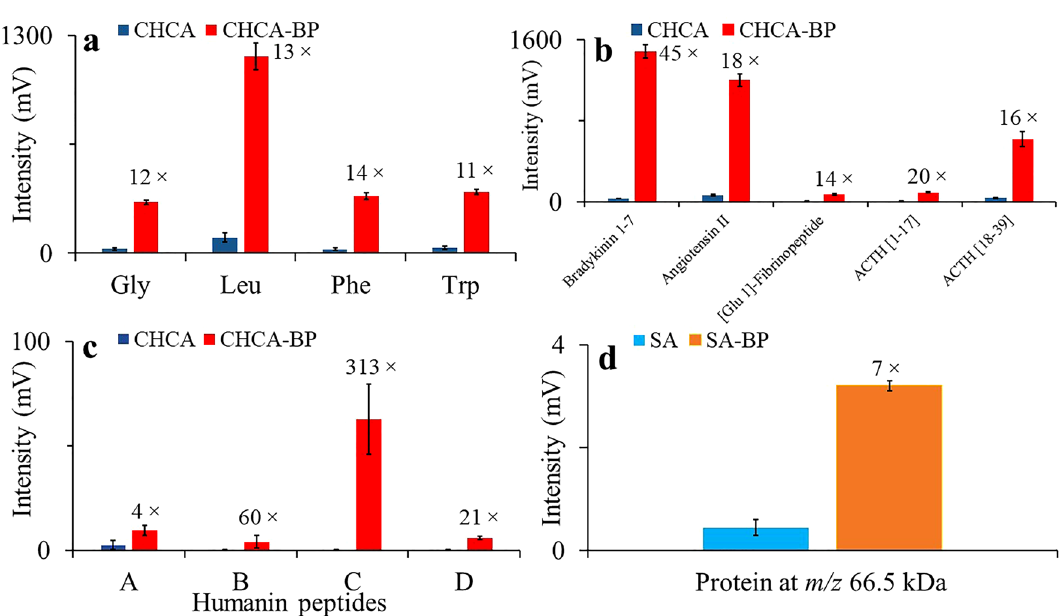
Figure 3. Black phosphorus improves peak intensity of amino acids, peptides, and proteins. ( a ) amino acids (intensity increment: 11–14 times, n = 4), ( b ) standard peptides (intensity increment: 14–45 times, n = 4), ( c ) humanin peptides (intensity increment: 4–313 times, n = 4), and ( d ) bovine serum albumin (BSA, intensity increment: 7 times, n = 5) using CHCA or SA matrix either alone or enriched by black phosphorus. Mass spectra were recorded in positive ion mode, laser energy 110 a.u. for amino acids and peptides and 180 a.u. for BSA, respectively. 100 spectral profiles were